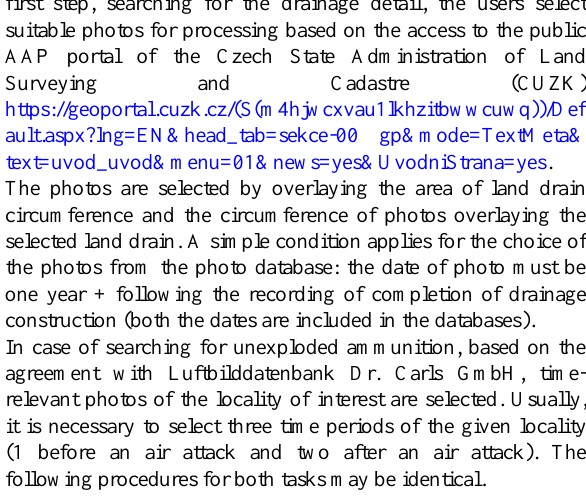
Figure 2. Distribution of FM in AAP 2.1.2